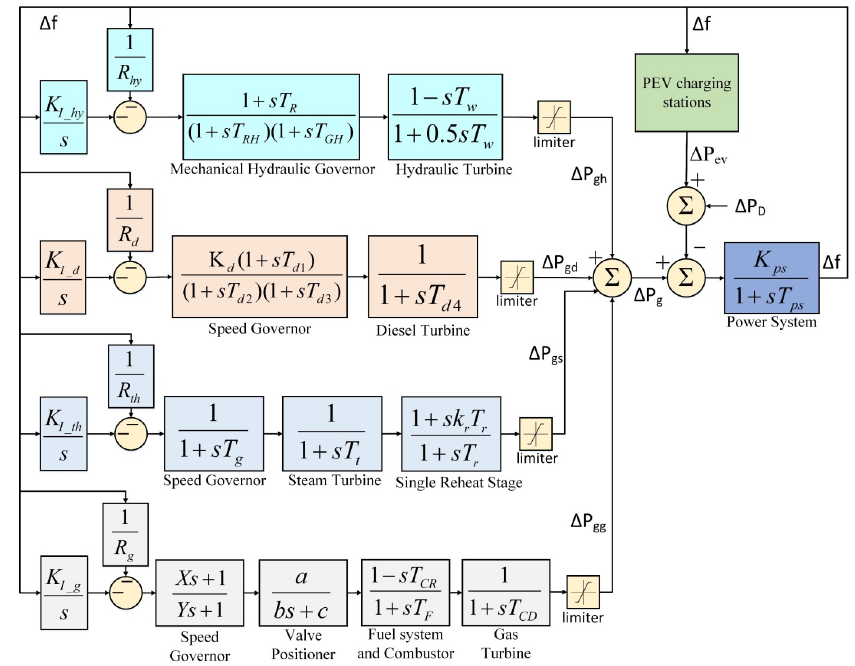
Figure 7. Transfer function block diagram representation of an isolated system with steam, hydro, diesel, and gas power generation units with their controllers and PEV support.